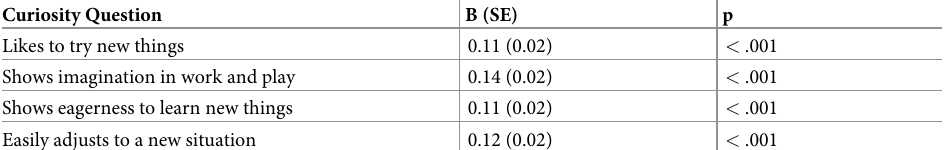
Table 4. Association between frequency of parent conversation during shared media viewing and each curiosity question item at kindergarten. Curiosity Question B (SE) p Likes to try new things 0.11 (0.02) < .001 Shows imagination in work and play 0.14 (0.02) < .001 Shows eagerness to learn new things 0.11 (0.02) < .001 Easily adjusts to a new situation 0.12 (0.02) < .001 B coefficients are unstandardized